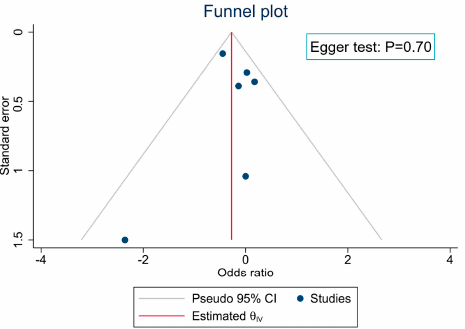
Figure 8. Publication bias and a small-study effect on the primary outcome.